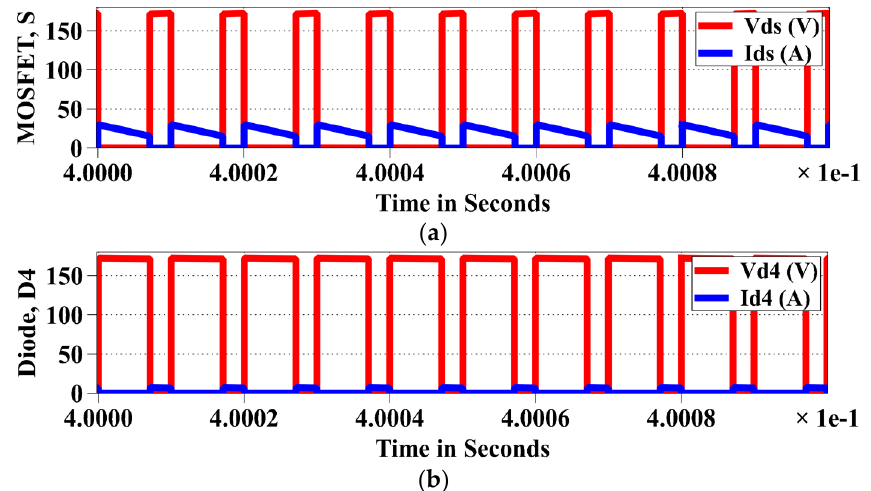
Figure 5. Current and voltage stress waveforms: ( a ) MOSFET switch, S; ( b ) Diode, D 4.